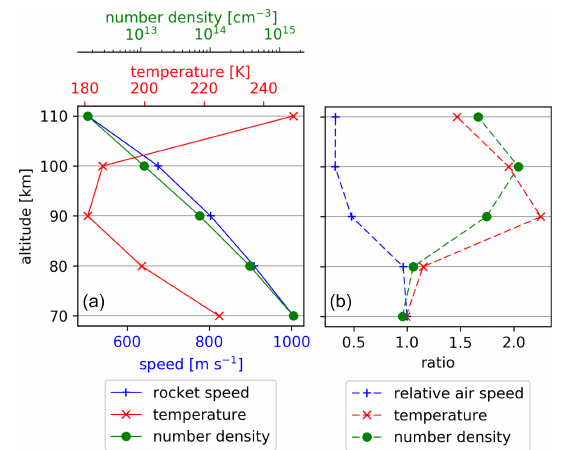
Figure 4. (a) DS2V simulation input parameters from the NRLMSISE-00 Atmosphere Model. (b) DS2V simulation results 1cm upstream of the inlet orifice plotted as a ratio to ambient values of relative air speed, atmospheric temperature and number